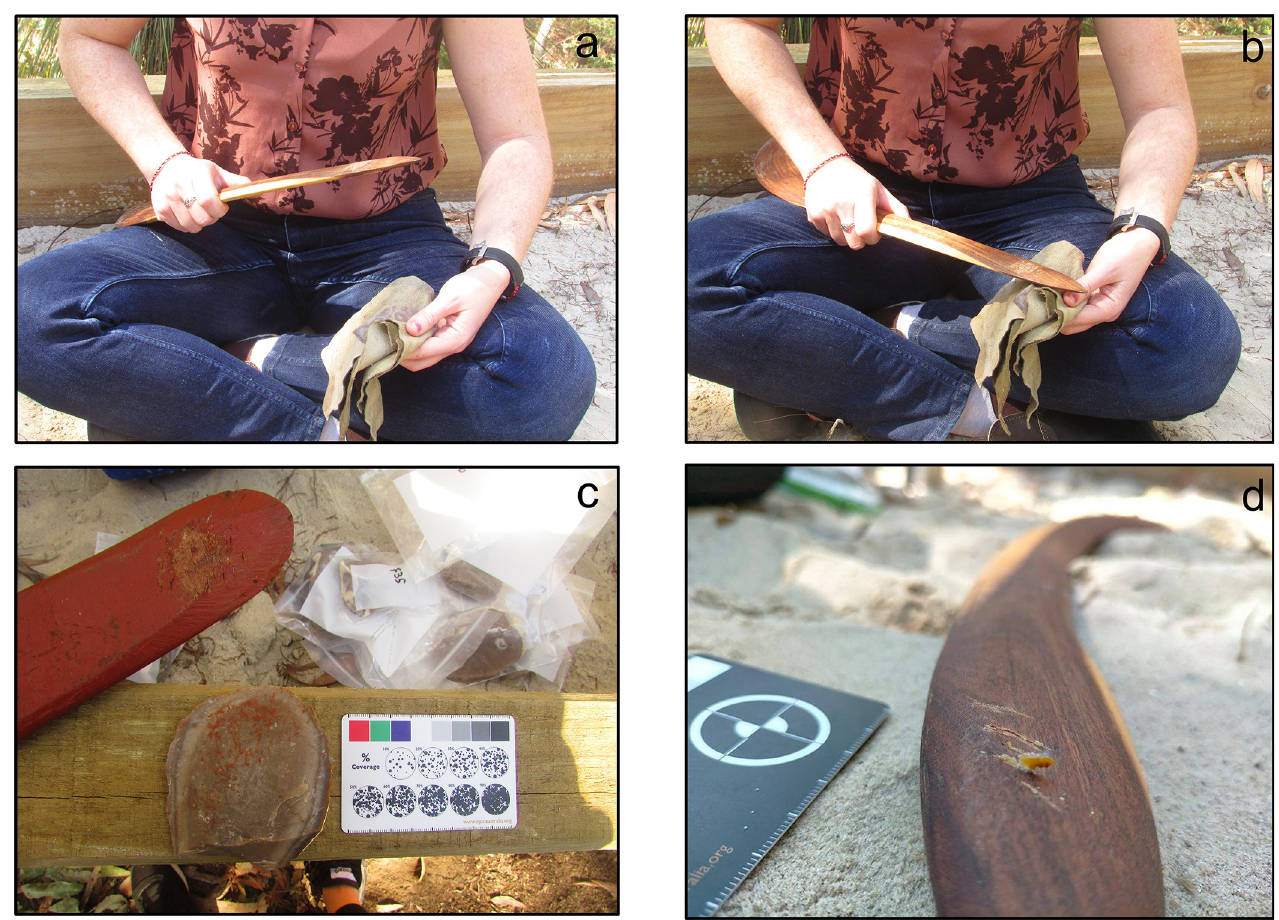
Fig 1. Retouching session 2 using boomerangs. (a, b) tangential movement of retouch; (c) use area B1_1 and retouched lithic flake F56; as this boomerang is painted, the ventral face of the flake shows residues of paint oriented according to the percussion movement of retouch; (d) flint chip embedded within retouch impact traces at the initial stage of